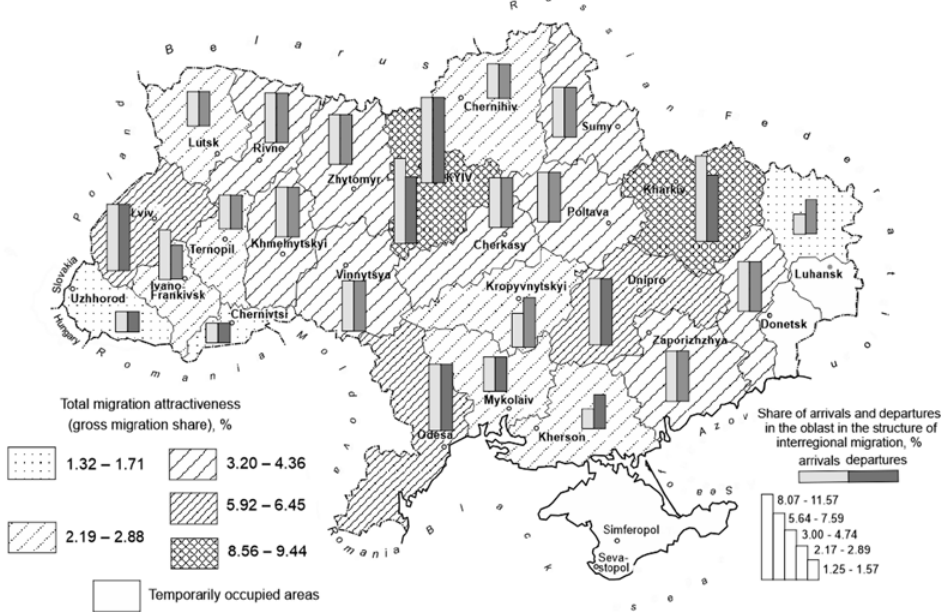
Figure 6. Regional structure of internal migration of Ukrainian population: shares of arrivals, departures, and gross migration in